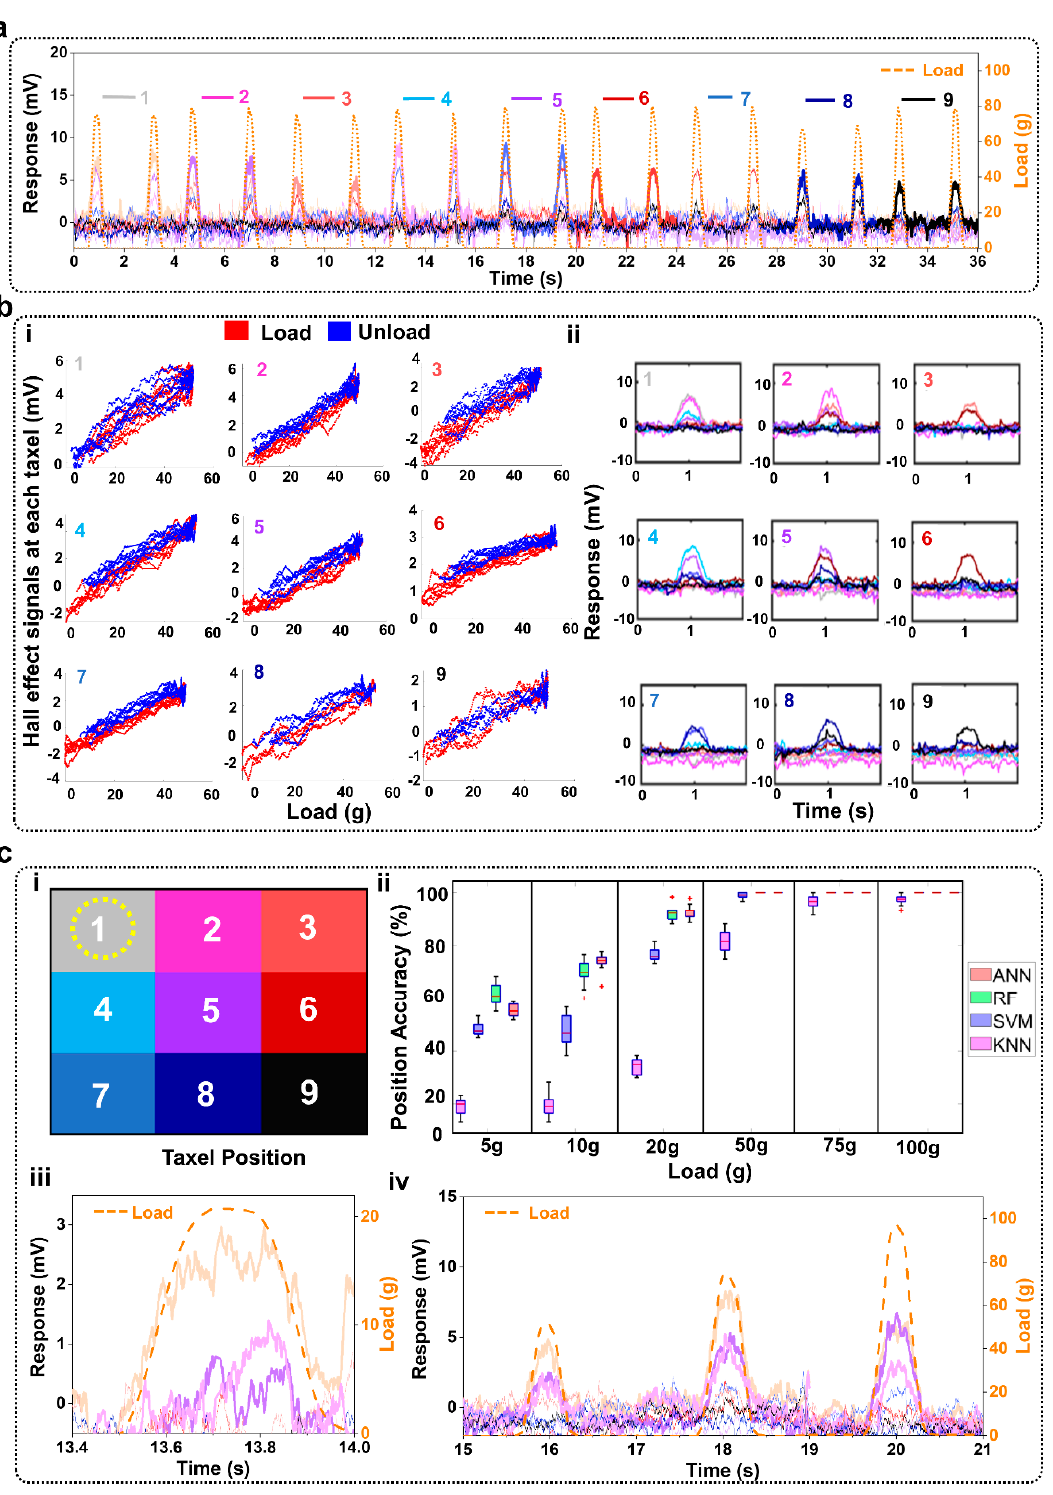
Figure 3. Classification accuracy of 10% ferrofluid soft magnetic sensor array. ( a ) Illustrative responses and load cell data at the nine taxel locations with a 75 g load. ( bi ) Load changes with Hall effect signals at each taxel, ( bii ) Individual taxel responses under 100 g load. ( ci ) Hall effect sensor taxel position. ( cii ) Classification accuracies to detect the different locations a load was applied with each of the six different loads (n = 30 repetitions/load). ( ciii ) Taxel responses under 20 g load applied at taxel 1. ( civ ) All taxel responses under different loads (50 g, 75 g, 100 g) applied at taxel 1.